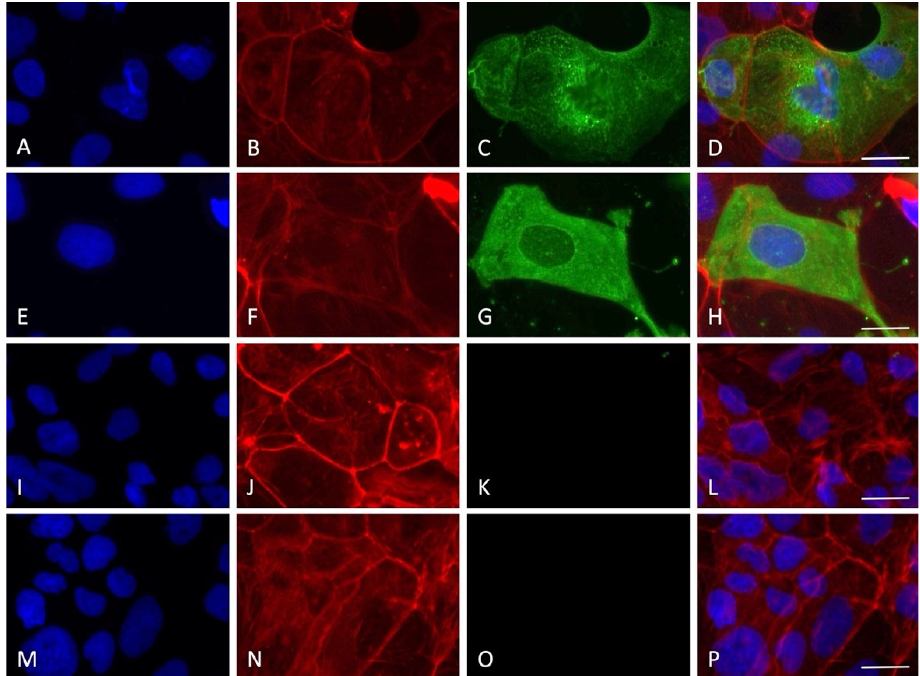
Figure 6. Immunofluorescence staining for nucleocapsid SARS ‐ CoV ‐ 2 protein with the experimental protocol employing 15 min of viral absorption (60× magnification, scale bar 30 micron). The fluorescence for nucleus (blue), F ‐ actin cytoskeleton (red), nucleocapsid protein of SARS ‐ CoV ‐ 2